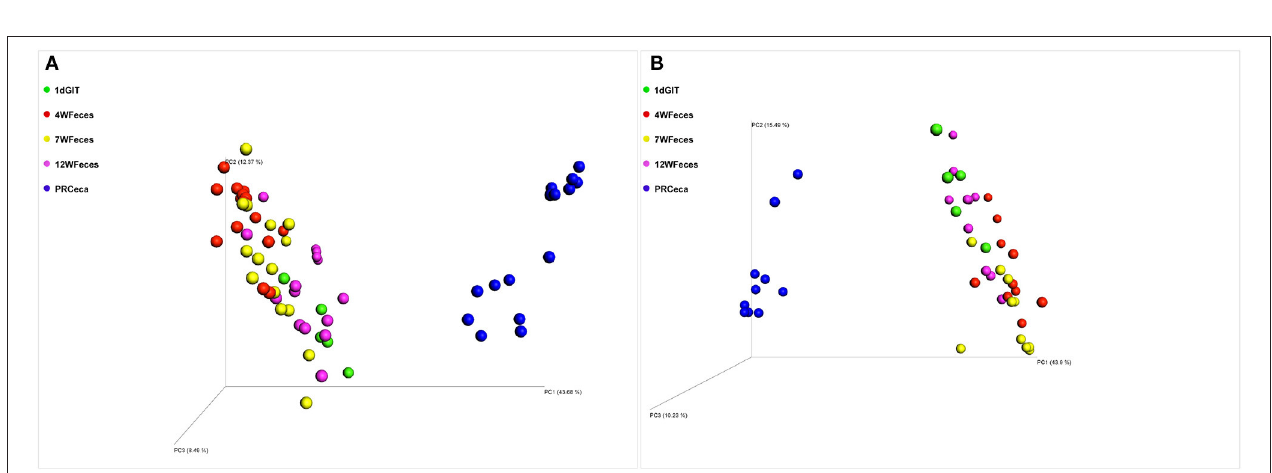
FIGURE 5 | Principal coordinate analysis (PCoA) of beta-diversity of pasture-raised chicken using Weighted UniFrac distances: 1dGIT, Gastrointestinal contents from 1-day-old broilers; 4WFeces, Feces from 4-week-old broilers; 7WFeces, Feces from 7-week-old broilers; 12WFeces, Feces from 12-week-old broilers; PRCeca, Cecal contents collected during slaughter. (A) Broilers fed a soy-containing diet; (B) Broilers fed a soy-free diet. Beta-diversity was significantly different ( P ≤ 0.001) across the sample types analyzed in both groups (A,B)